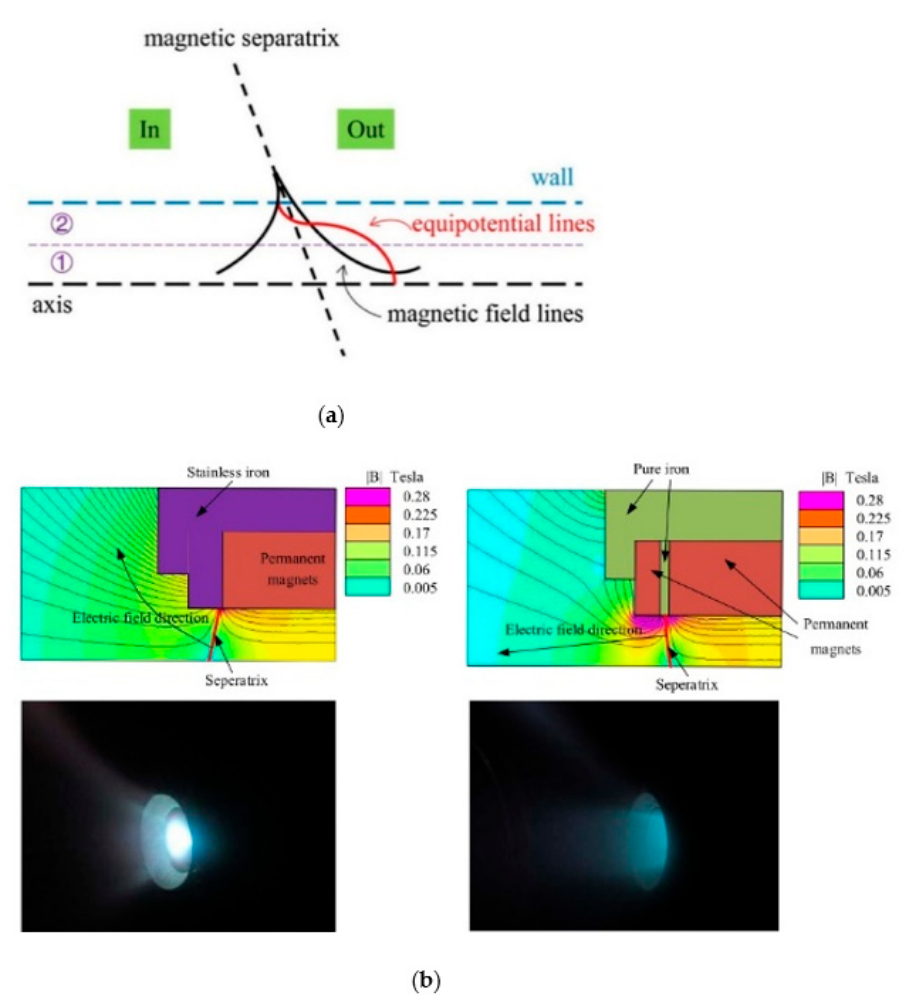
Figure 10. Last magnetic separatrix effects on plume divergence. A demonstration of the relation- ship between magnetic separatrix and equipotential lines ( a ) and an optimization on last magnet separatrix ( b ).